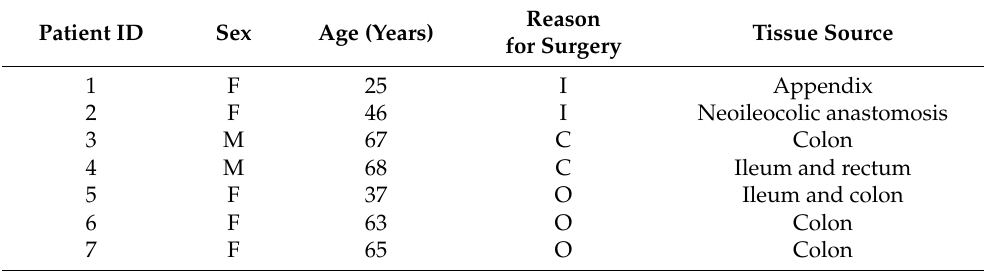
Table 1. Composition of the Cohort of Patients with Multiple Sclerosis.